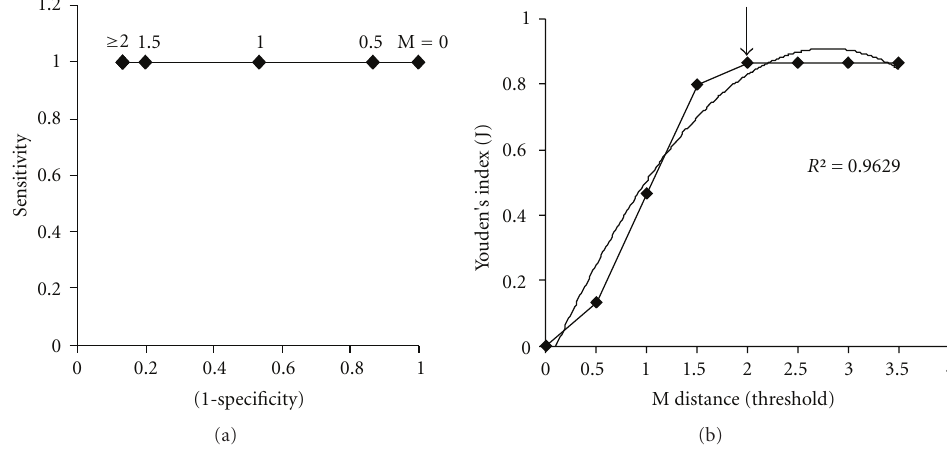
Figure 4: (a) Receiver Operating Characteristic (ROC) curve and (b) Youden’s index curve for normal calibration